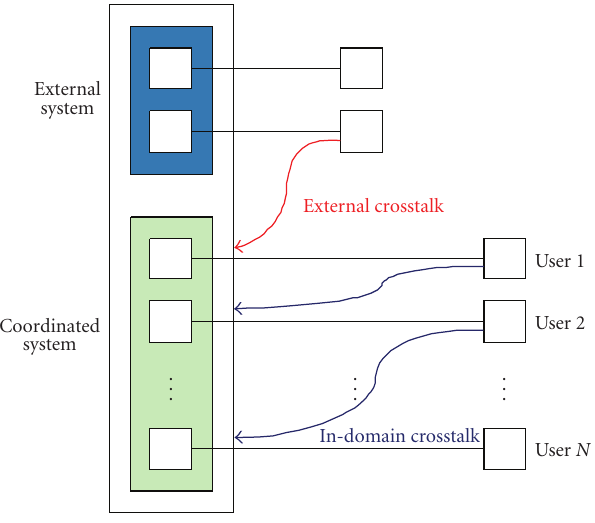
Figure 1: External crosstalk